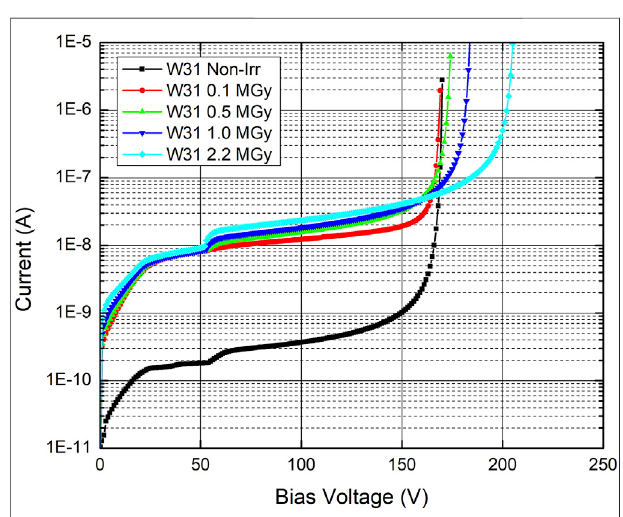
FIGURE 2 | Sample current versus voltage characteristics for LGADs from Wafer 31, for various gamma